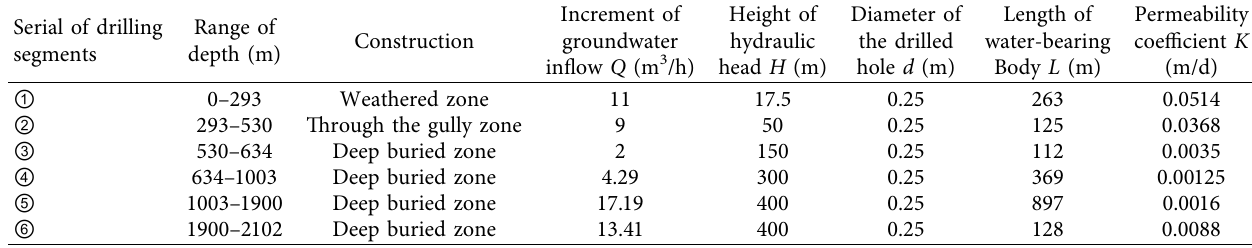
Table 2: Permeability coefficient of each section of the horizontal directional drilling exploration borehole, based on Goodman’s empirical